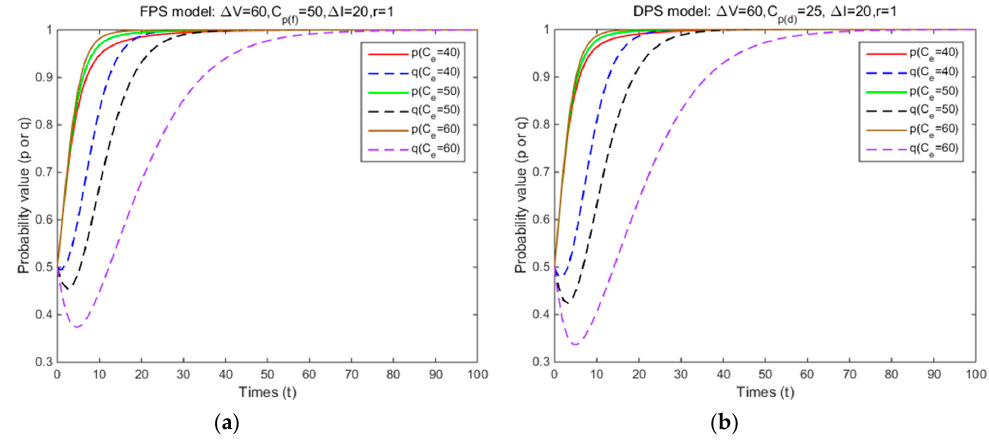
Figure A5. The effects of enforcement cost on strategy probabilities of cyclists and law enforcement under FPS ( a ) and DPS ( b ) (Situation 1).